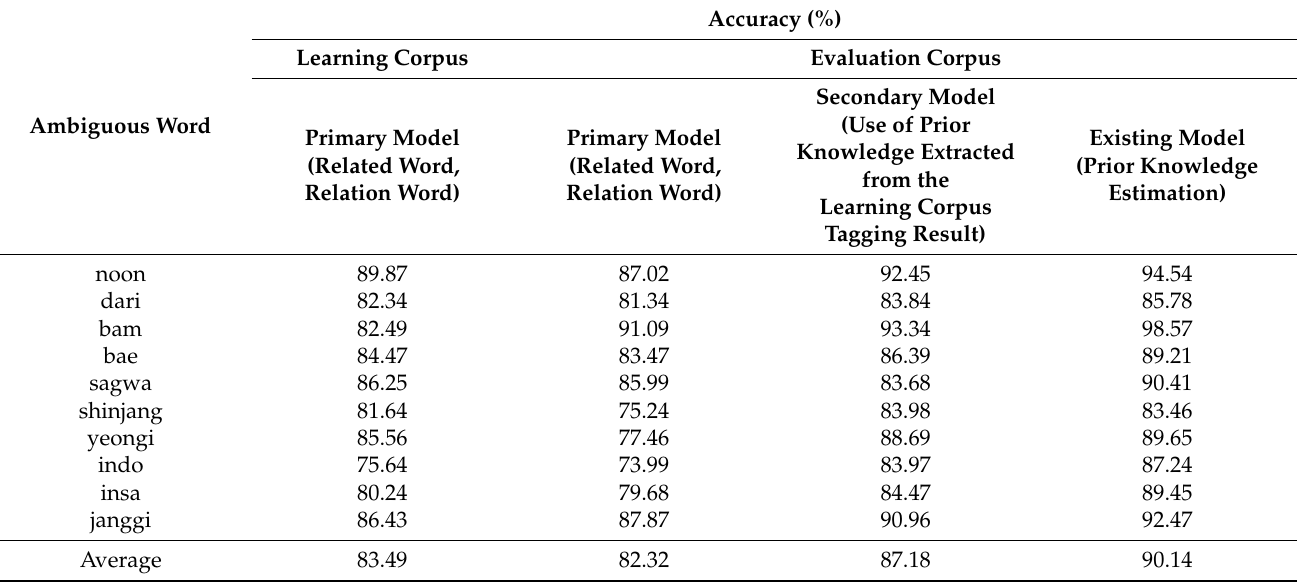
Table 9. The experiment result of effect analysis of prior probability